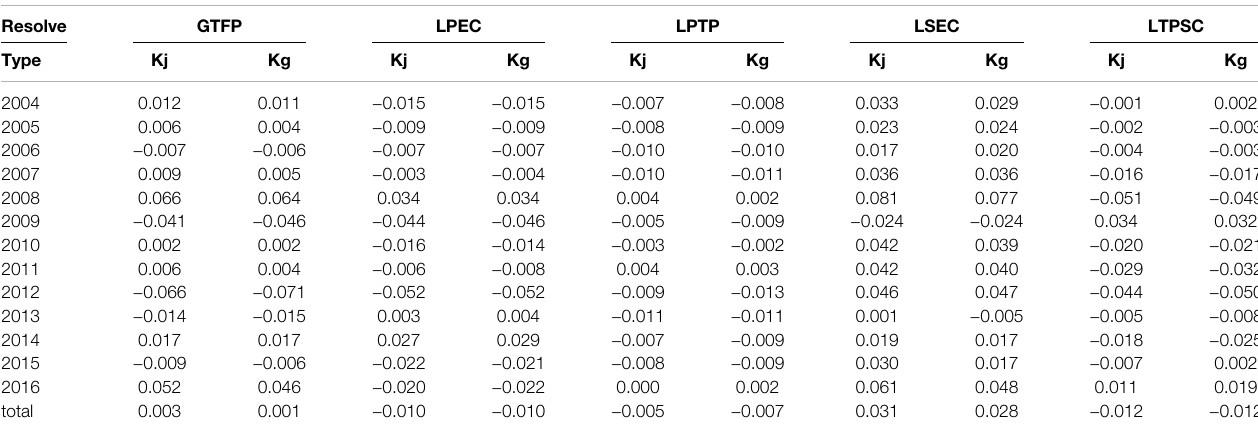
TABLE 4 | GTFP growth and its decomposition in the fourth case